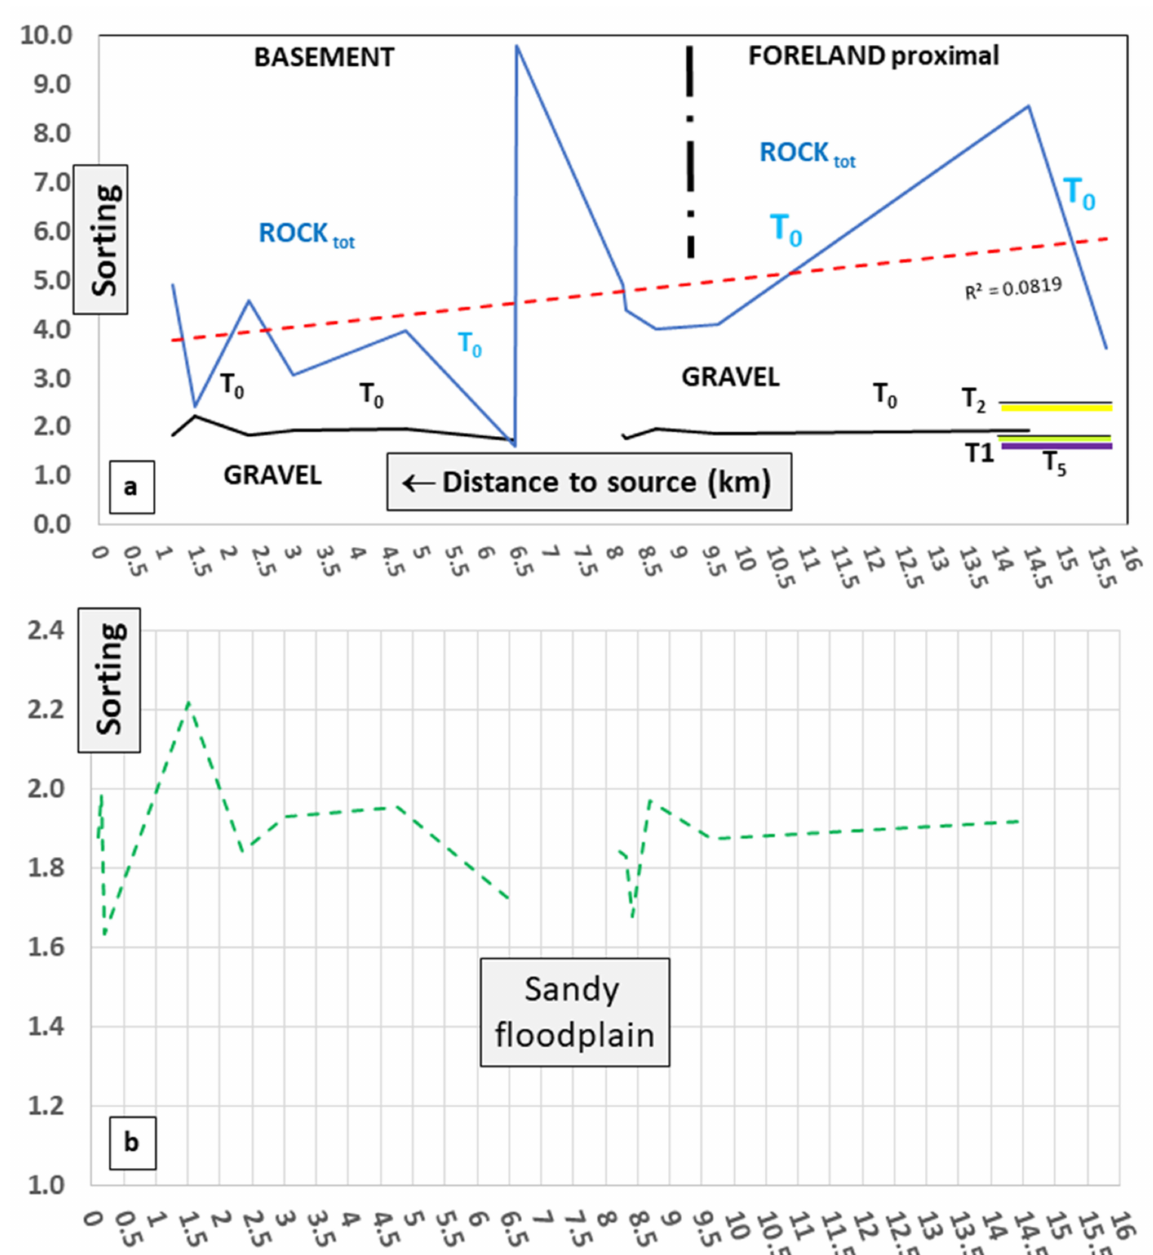
Figure 13. Sorting of sediments along the talweg as a function of distance to the source—see also Figure 5 for sedimentology. ( a ) Blue: sorting coefficient of the total rock sediments T0; black: sorting of the gravelly grain size fraction [94] of T0; red-stippled line: trend line with correlation coefficient; green: sorting of the gravelly grain size fraction of terrace T1; yellow: sorting of the gravelly grain size fraction of terrace T2; purple: sorting of the gravelly grain size fraction of terrace T5. ( b ) Close-up view of the sorting value of the gravel fraction as a function of distance to